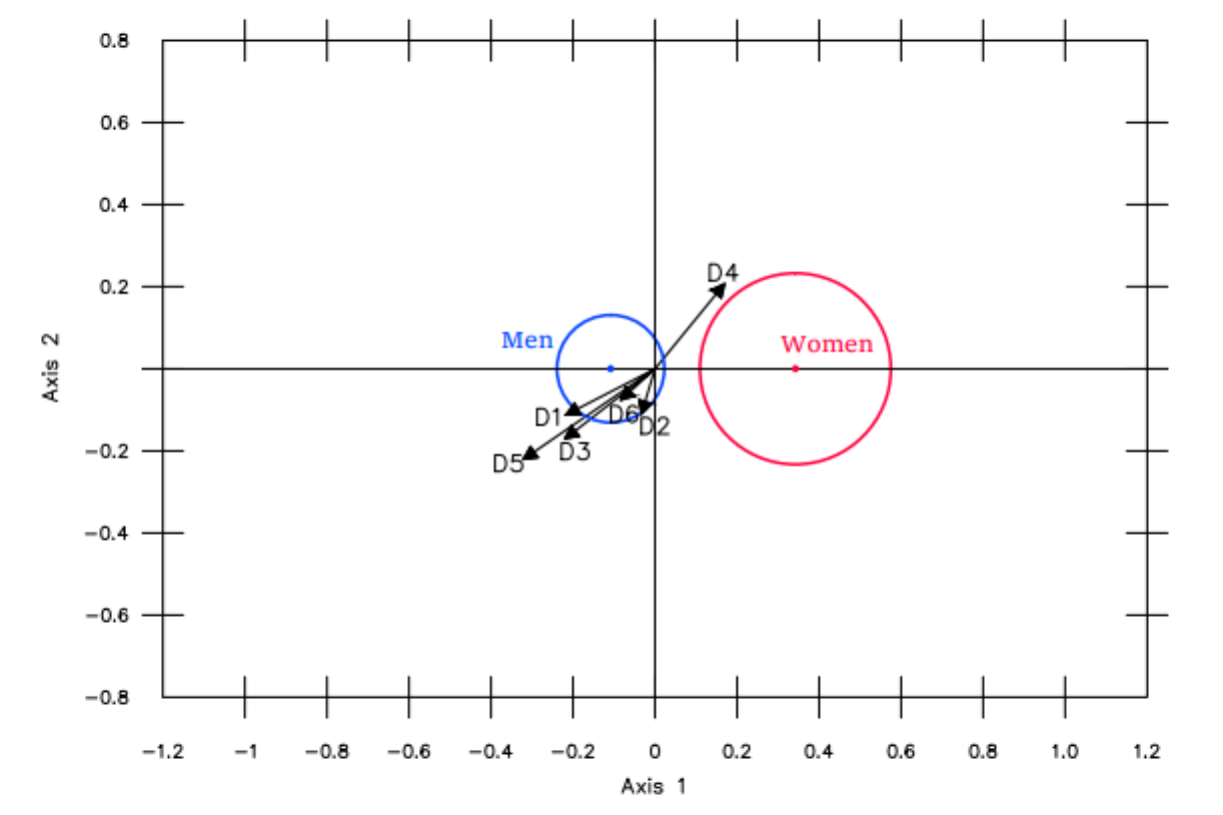
Figure 3. MANOVA Biplot comparing men and women.